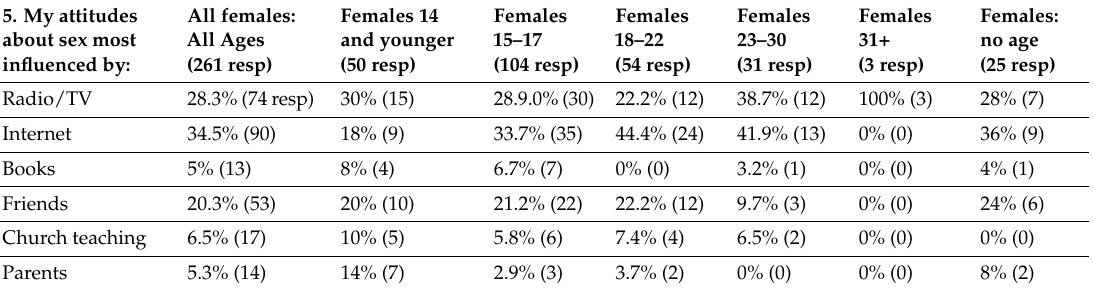
Table 6. Attitudes about Sex Most Influenced by? All